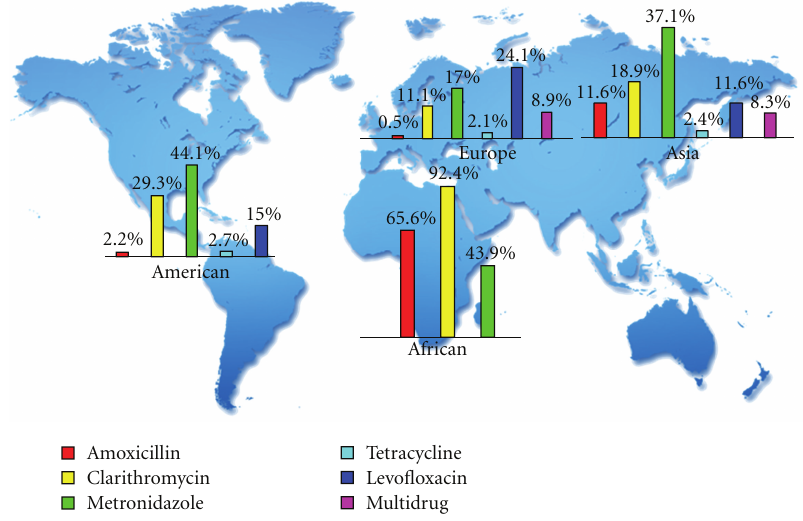
Figure 2: Antibiotic resistance rates in di ff erent continental